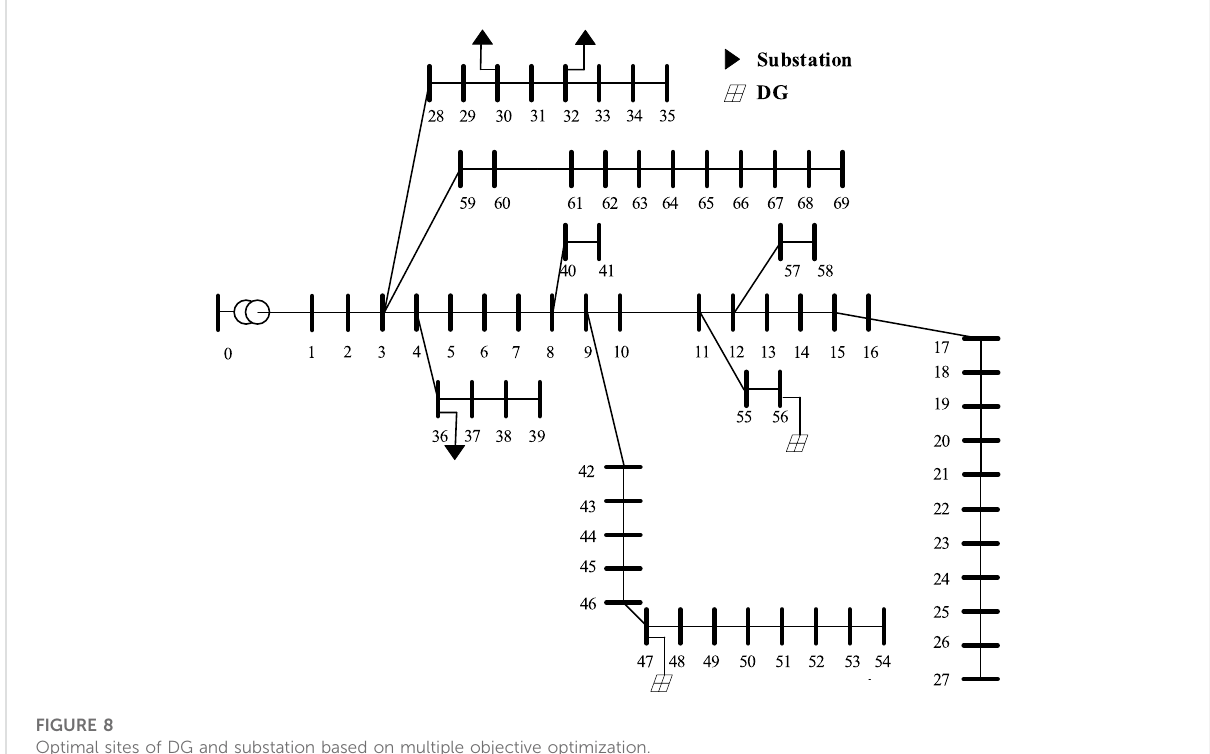
FIGURE 8 Optimal sites of DG and substation based on multiple objective optimization.